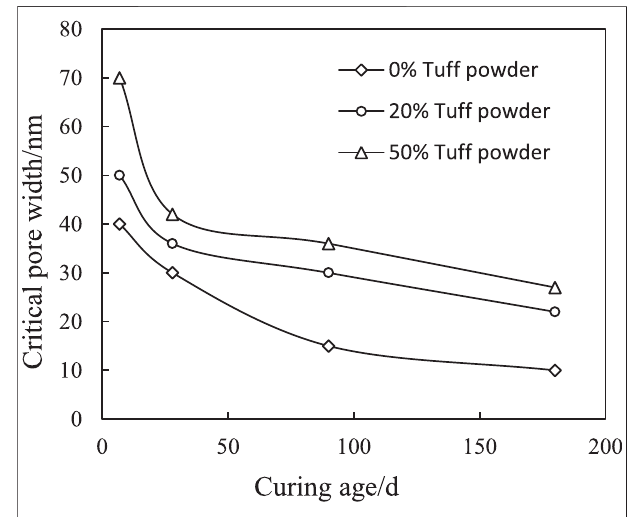
FIGURE 5 | The differential pore size distribution curves of tuff powder- cement hardened paste.